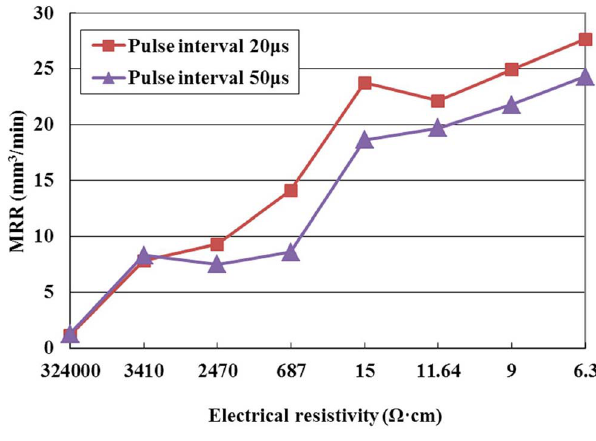
Figure 6. Effect of the tool polarity on EWR.